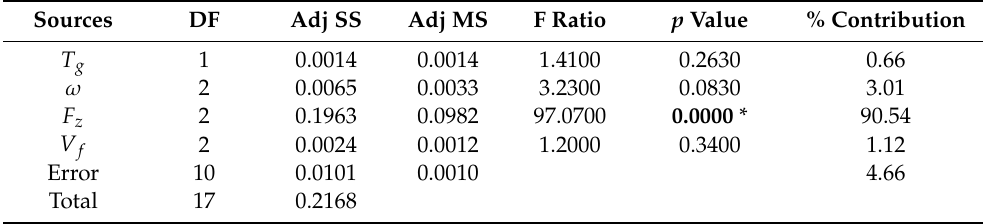
Table 6. ANOVA table for Torque ( T ).